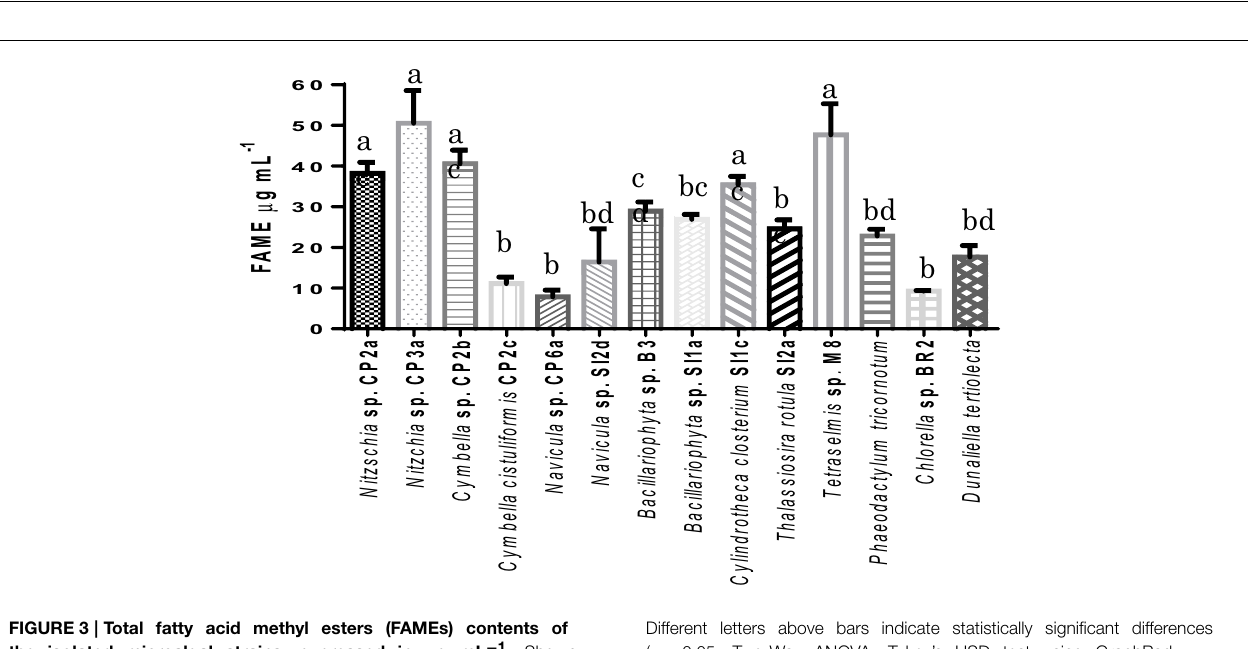
Different letters above bars indicate statistically significant differences ( p < 0 . 05 ; Two-Way ANOVA, Tukey’s HSD test using GraphPad Prism